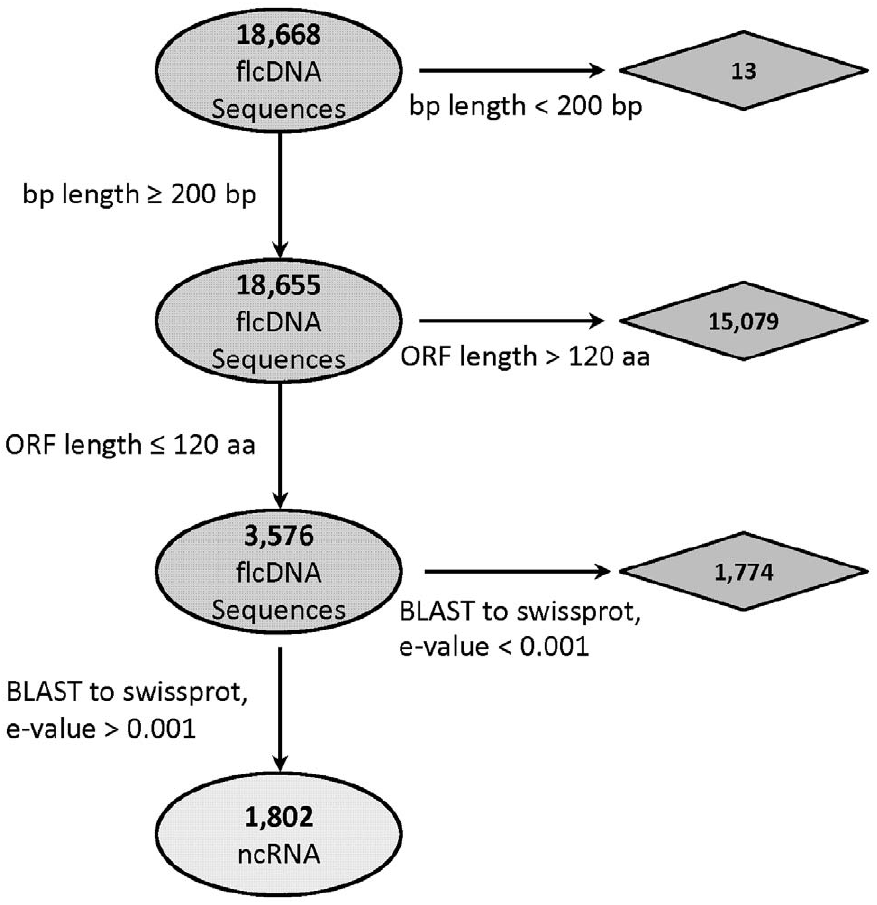
Figure 1. Python pipeline results on 18, 668 full-length cDNAs. The starting data set for the pipeline are 18,668 full-length cDNA sequences. The sequences are sequentially analyzed for protein coding potential using ORF length and homology of predicted protein with known proteins as indications of coding potential. The full-length cDNA sequences that pass through are designated as noncoding RNAs (ncRNAs) and are contained in Dataset S1 (supplementary data).